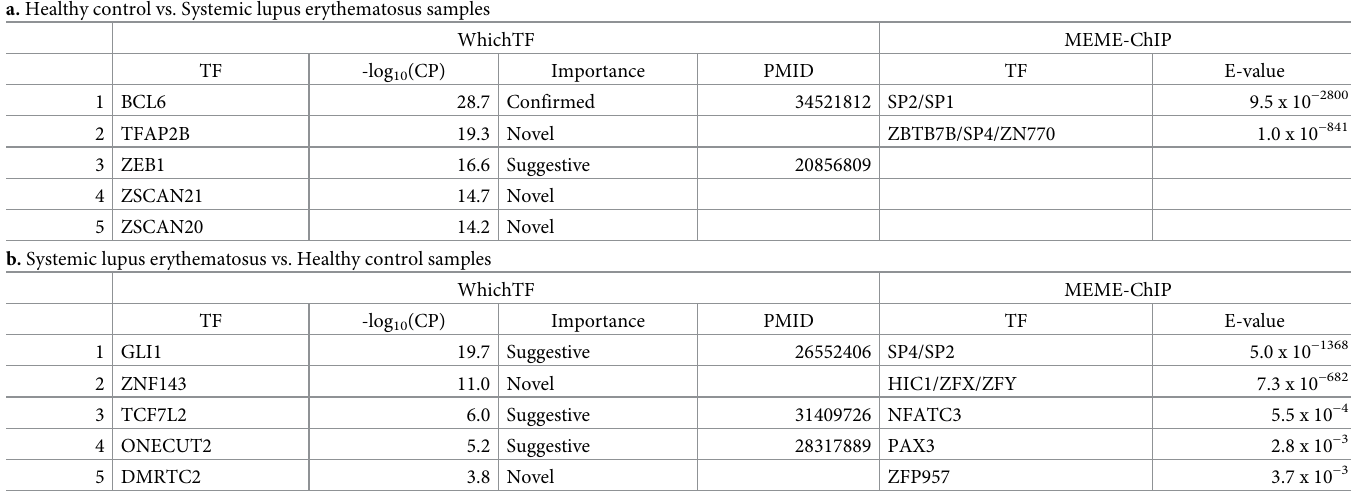
Table 3. WhichTF identifies differentially dominant TFs from ATAC-seq measurement of B-cells from systemic lupus erythematosus (SLE) patients versus healthy controls (HC). a. Healthy control vs. Systemic lupus erythematosus samples